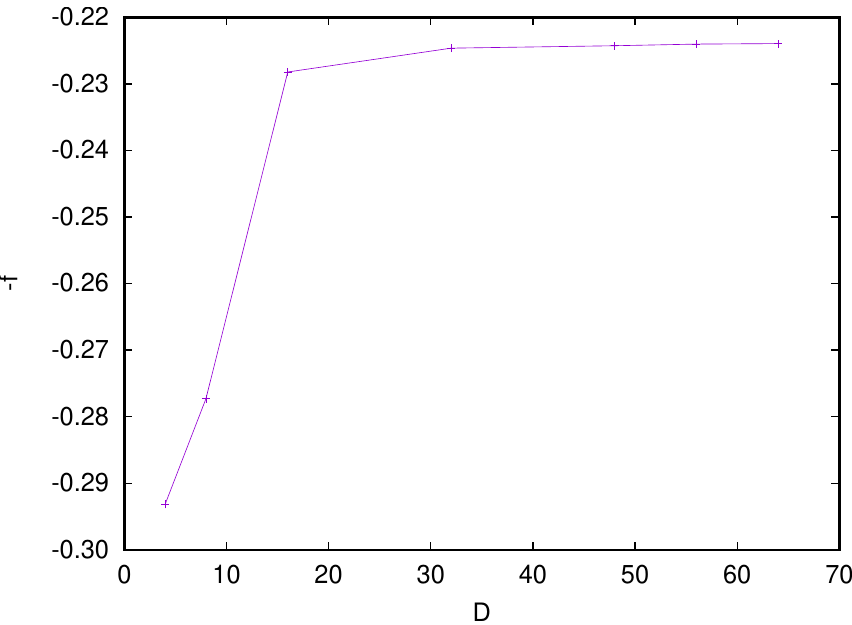
Figure 2 . Free energy density for K = 64 and m 2 = 0 : 01, (cid:21) = (cid:22) = 1 on V = 1024 2 .